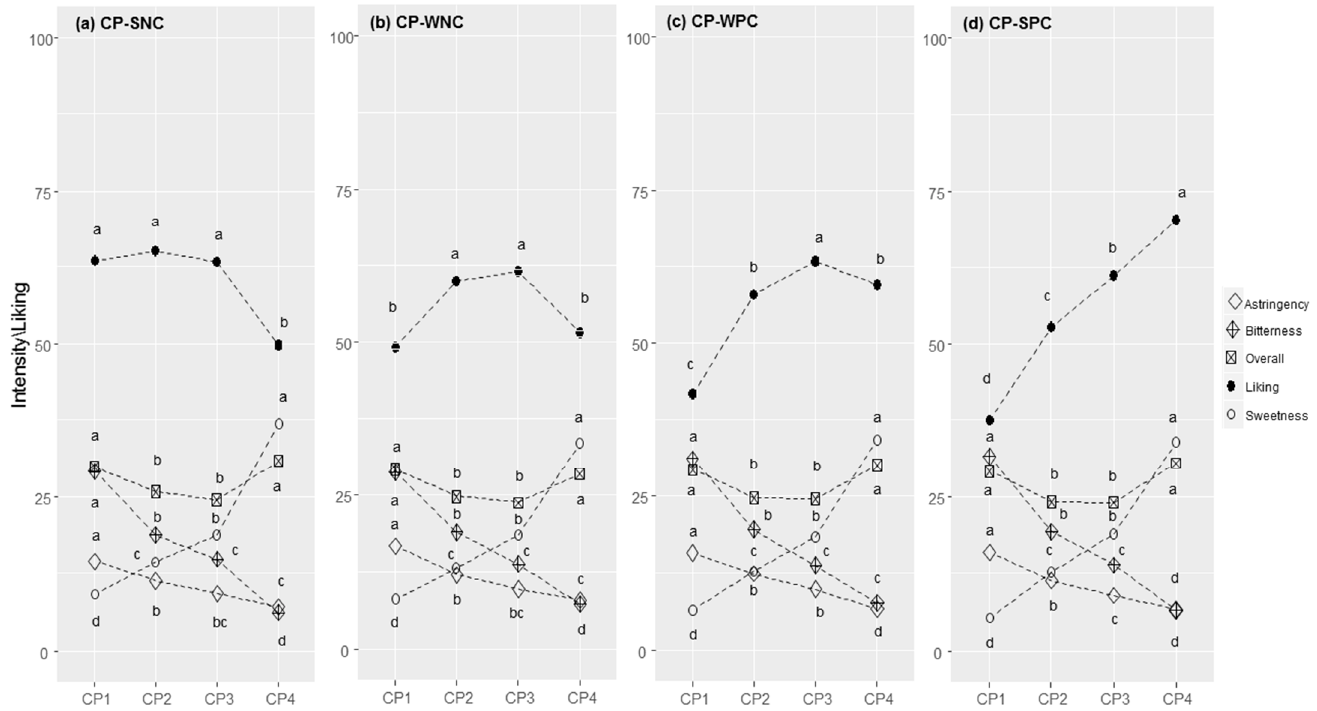
Figure 4. Chocolate Pudding (CP) responses in each cluster (SNC = Strong Negative Correlation ( a ), WNC = Weak Negative Correlation ( b ), WPC = Weak Positive Correlation ( c ), and SPC = Strong Positive Correlation ( d )): perceived intensity (gLM scale) and liking (LAM scale) for samples at increasing concentrations of sucrose (1–4). Within each cluster, different letters indicate significant differences in intensity/liking between concentration levels ( p < 0.05).